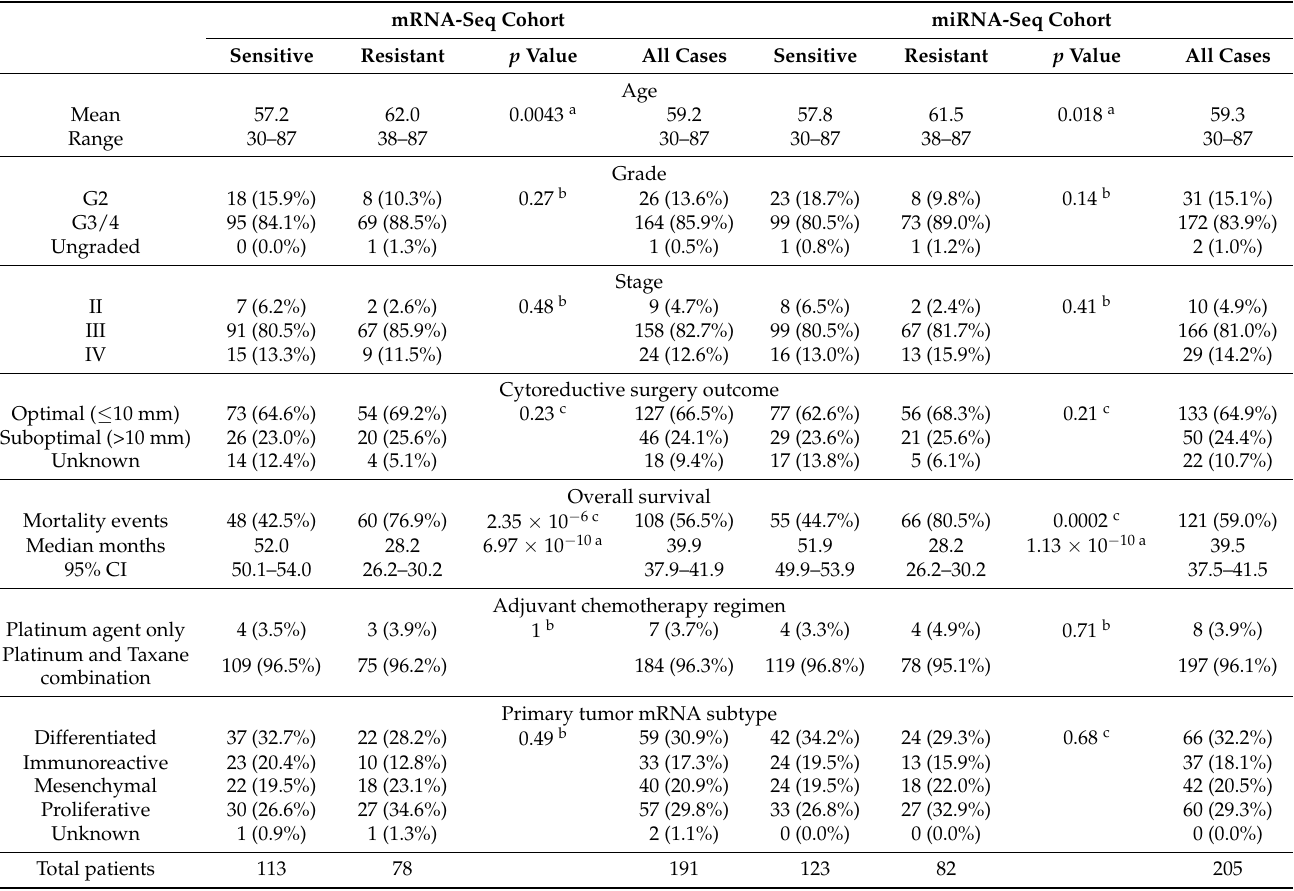
Table 2. Characteristics of the HGSOC cohorts with mRNA-Seq and miRNA-Seq data from